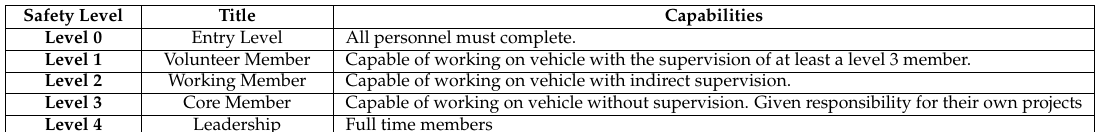
Table 5. Safety Levels and Associated Titles.